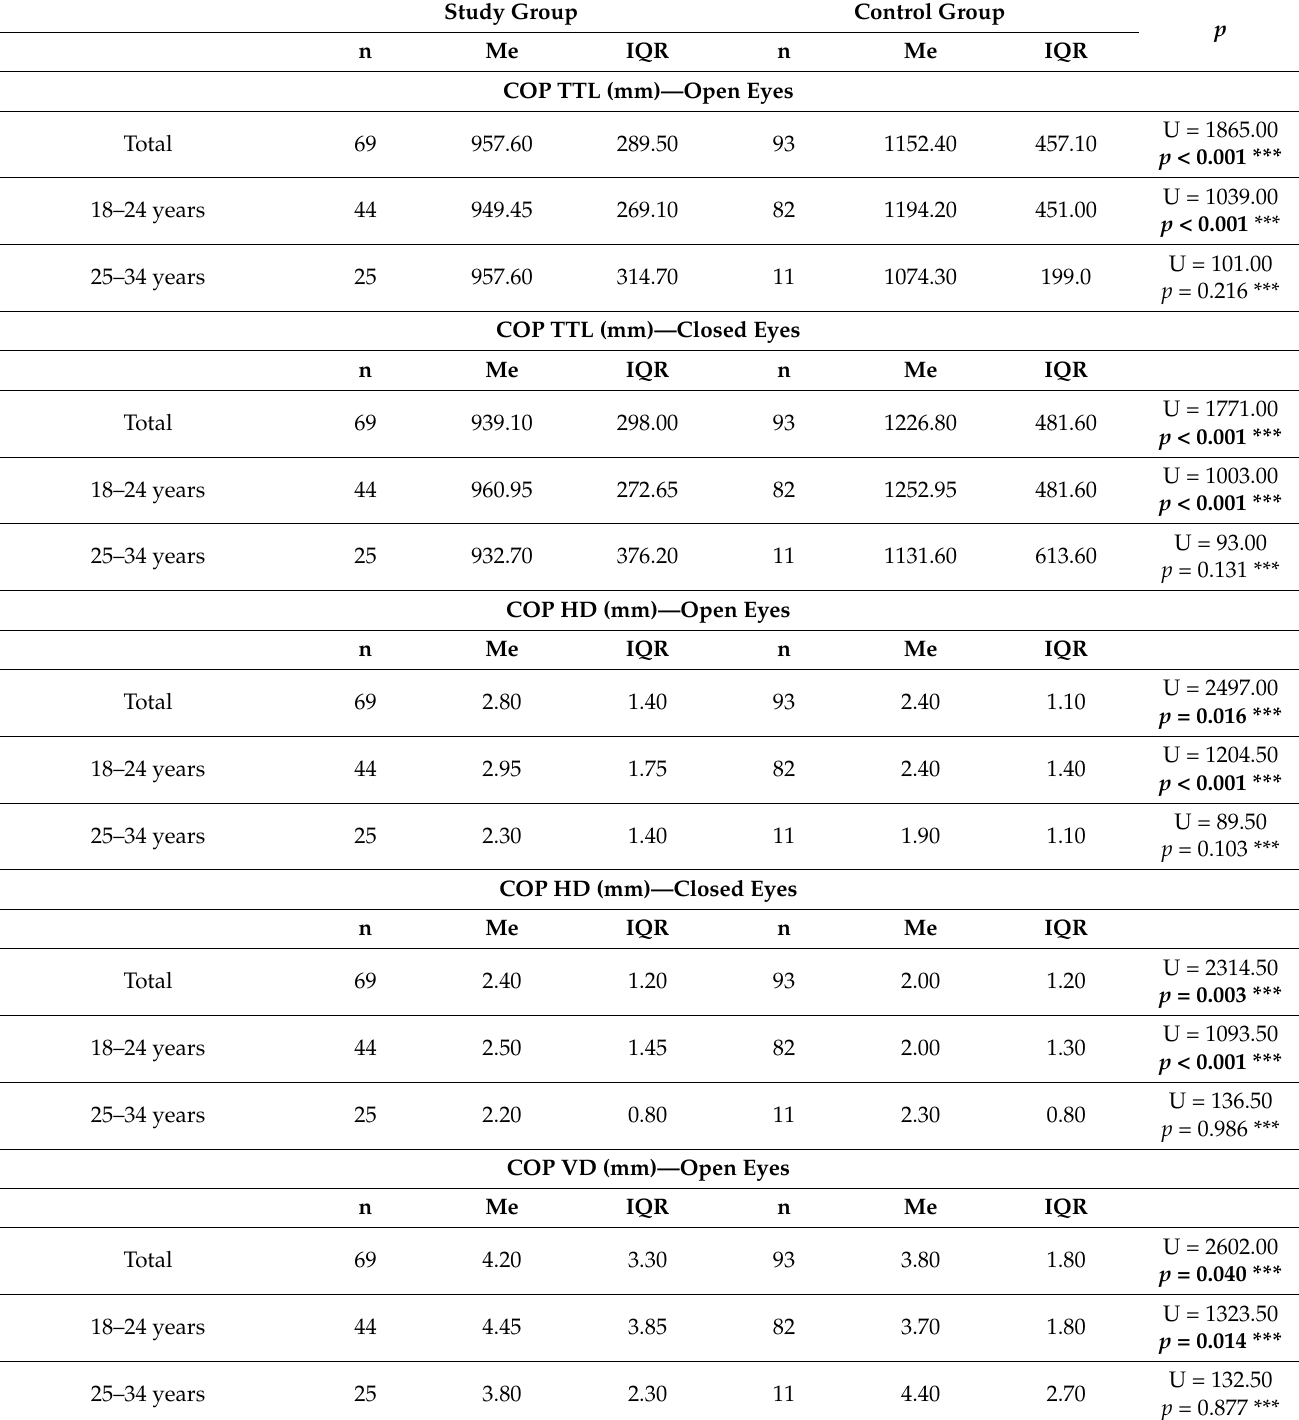
Table 3. Differences in the values of the center-of-pressure considering the age of the participants. Study